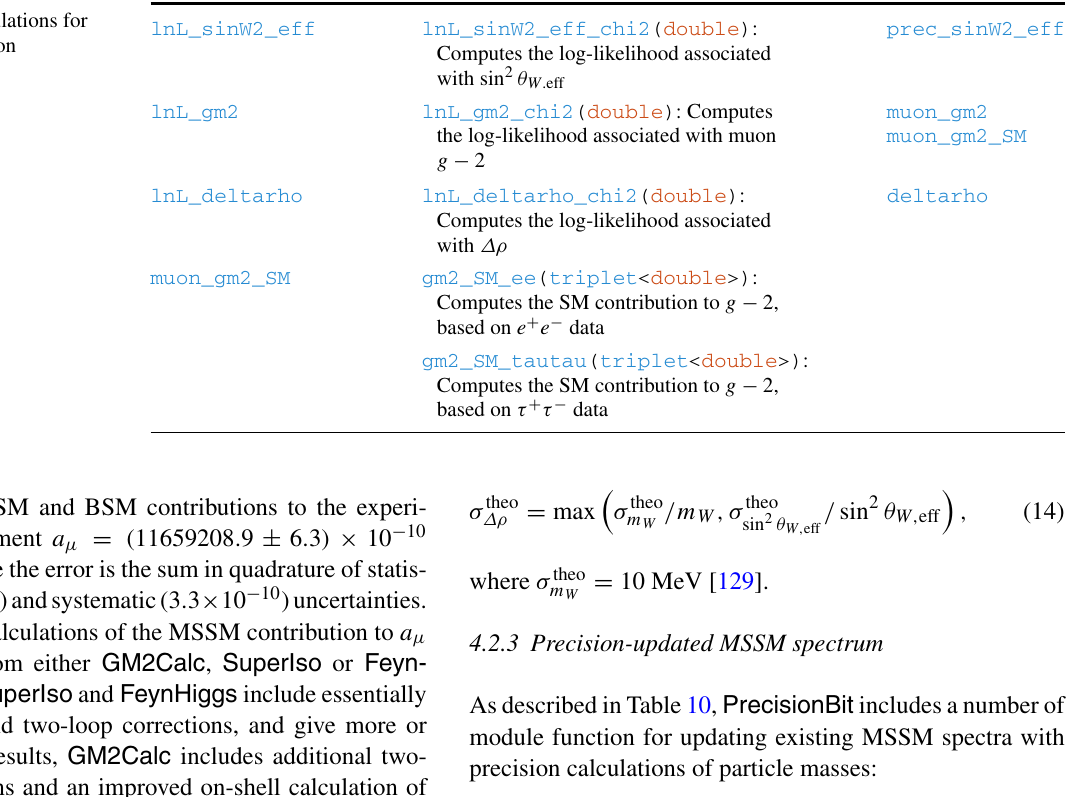
Table 11 PrecisionBit module functions providing log-likelihood calculations for electroweak precision